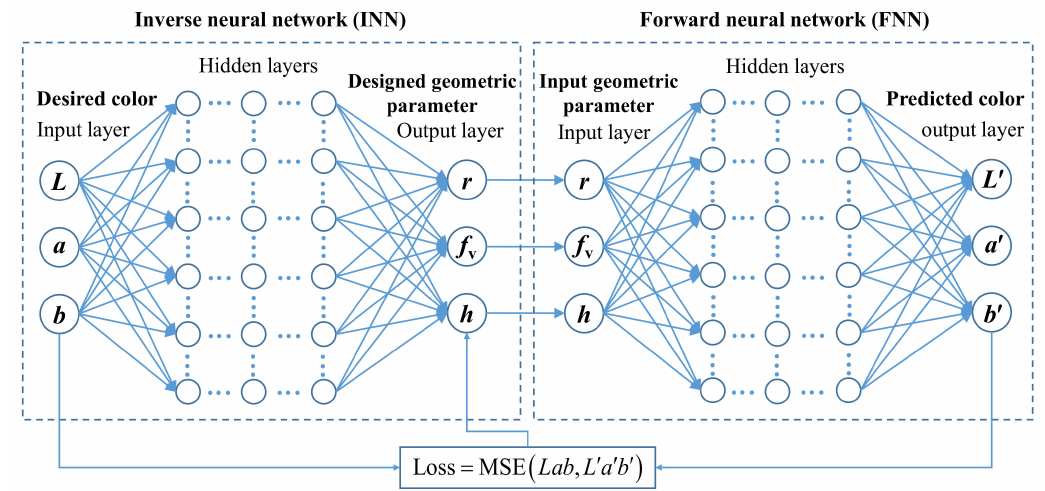
Figure 3. Simplified schematic of the multilayered BNN model that consists of a fully connected INN that directly connects to a pre-trained